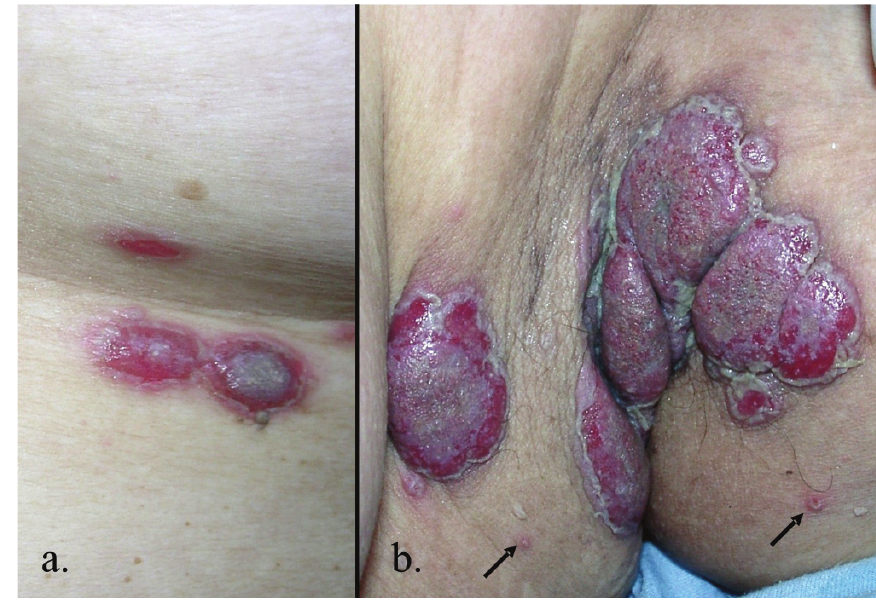
Figure 1 - a. vegetating plaques on the inframammary fold. b.similar lesions in the axilary fold with two small blisters (arrows)